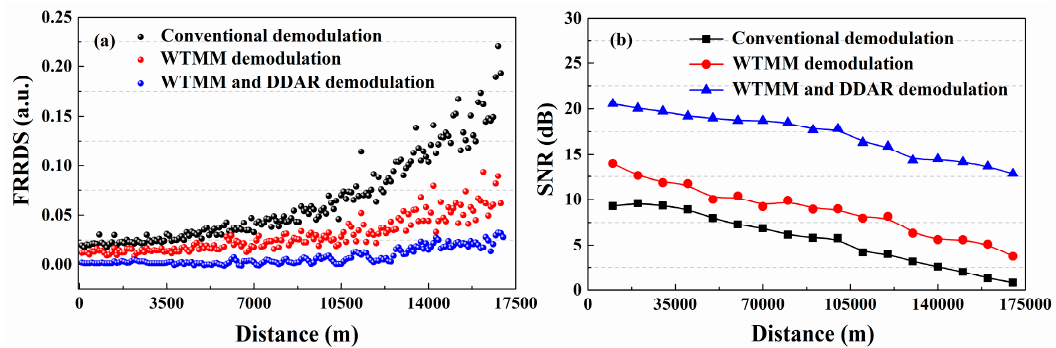
Figure 5. The ( a ) fluctuation range of Raman demodulation signal (FRRDS) trends and ( b ) signal-to-noise Figure5. The( a )fluctuationrangeofRamandemodulationsignal(FRRDS)trendsand( b )signal-to-noise ratio (SNR) measurement results for DDP scheme using the different demodulation methods. ratio (SNR) measurement results for DDP scheme using the di ff erent demodulation